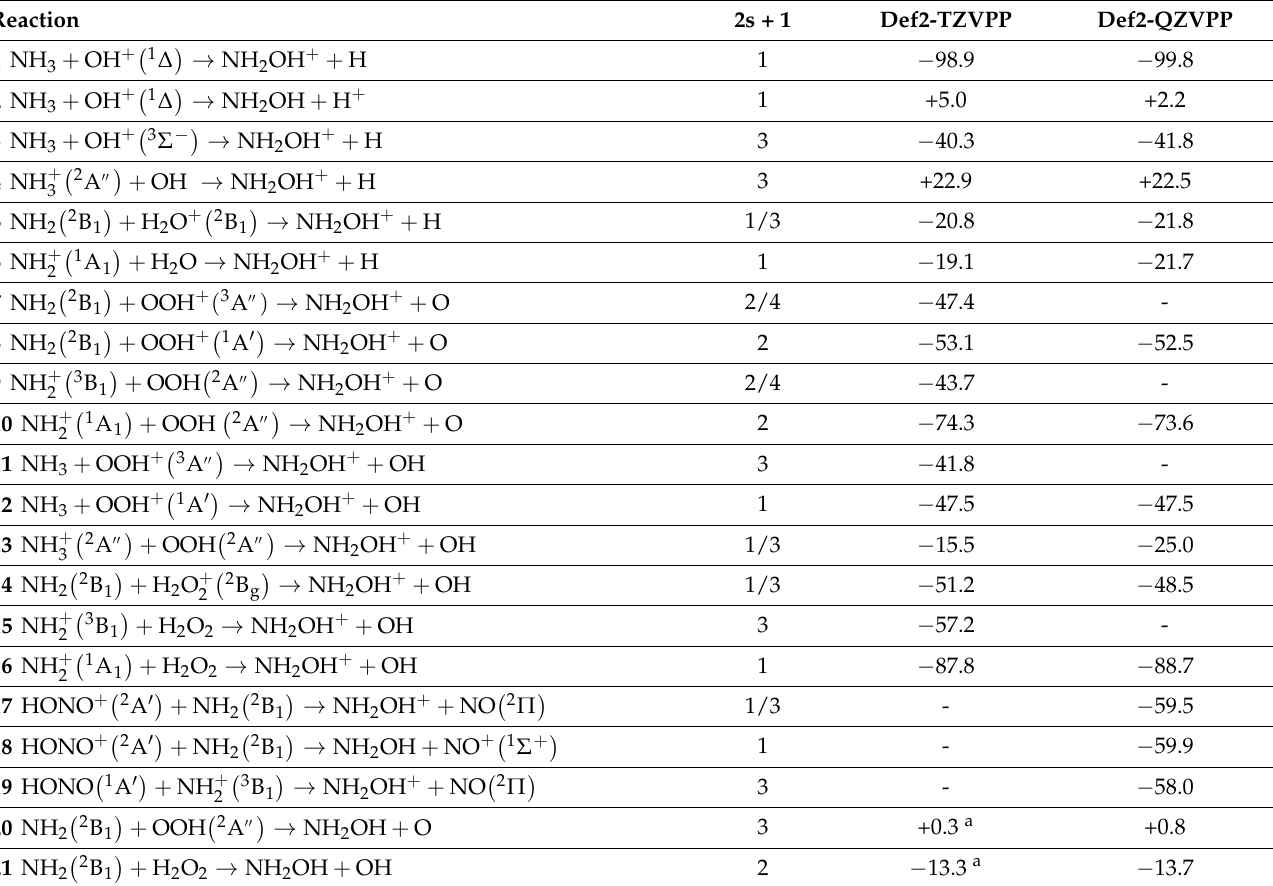
Table 1. List of the reactions examined in this work, along with their reaction energies (kcal/mol), corrected for ZPE. Geometries and ZPEs are calculated at the MP2 or DFT level. Electronic ener- gies are at the CCSDT(T) level. When not obvious, the term symbol of the molecular species has been